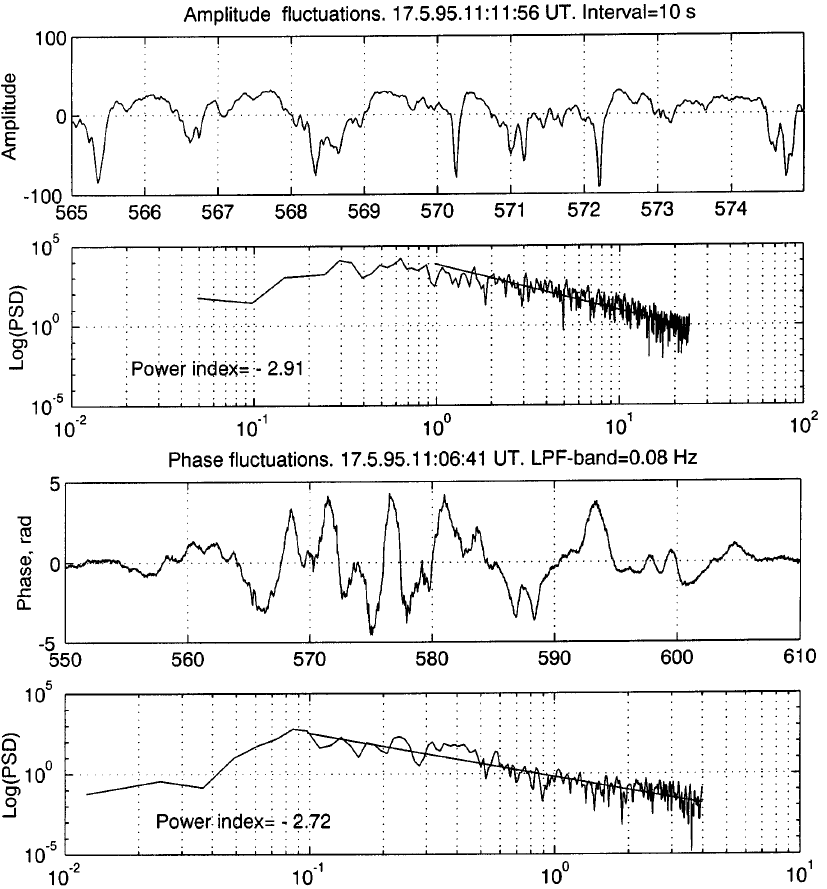
Fig. 5. Amplitude and phase fluctuations of the satellite signal and their power spectral densities (PSD) for the experiment shown in Fig. 2. The PSD of the amplitude ( second panel from the top) is obtained from the de- trended amplitude in a 10 s-interval ( top panel ). The PSD of the phase ( bottom panel ) is computed from the small-scale variations of the phase filtered by a low-pass filter with 0.08 Hz cut-o(cid:128) ( third panel ). The x -axes of the 2nd and 3rd panels show seconds from the data acquisition start time at